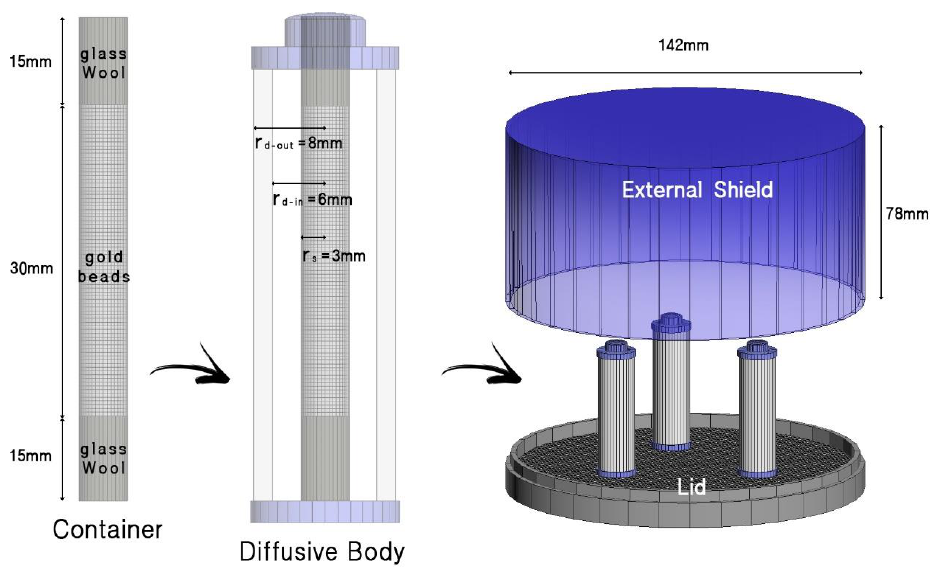
Figure 1. Passive sampler designed and used in this study.